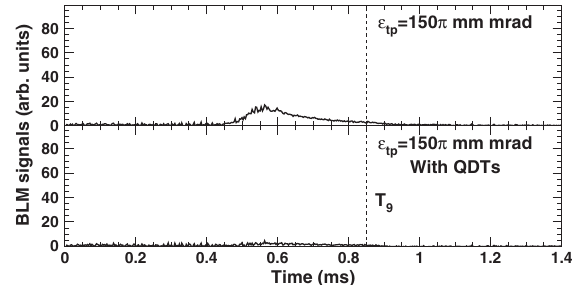
FIG. 19. Scintillation-type BLM signals over the first 1.4 ms measured in the collimator section with a beam intensity of 740 kW, where the chromaticity correction sextupole fields were reduced by half: (top) 150 π mm mrad transverse painting, and (bottom) 150 π mm mrad transverse painting with